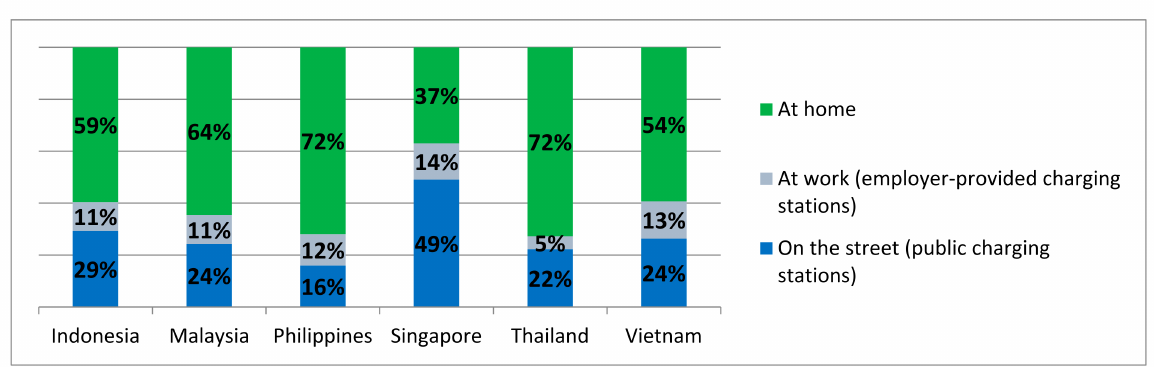
Figure 8. Consumers’ expectations for the availability of EV charging facilities in selected ASEAN countries. Source: https://www2.deloitte.com/content/dam/Deloitte/sg/Documents/strategy/sea-strategy-operations-full-sp eed-ahead-report.pdf (accessed on 4 November 2021) [53].